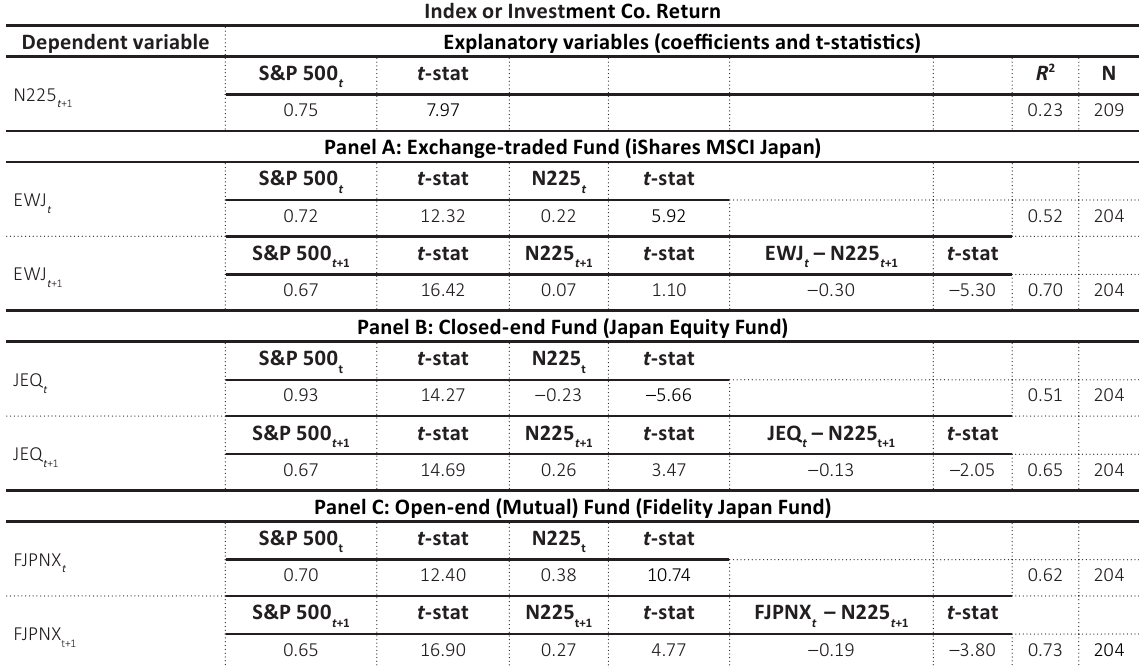
Table 1. Regression estimates for the determinants of Japanese equity investment company returns using daily returns for 2006–2010 for the days when the S&P 500 daily return was –1% or lower Index or Investment Co.